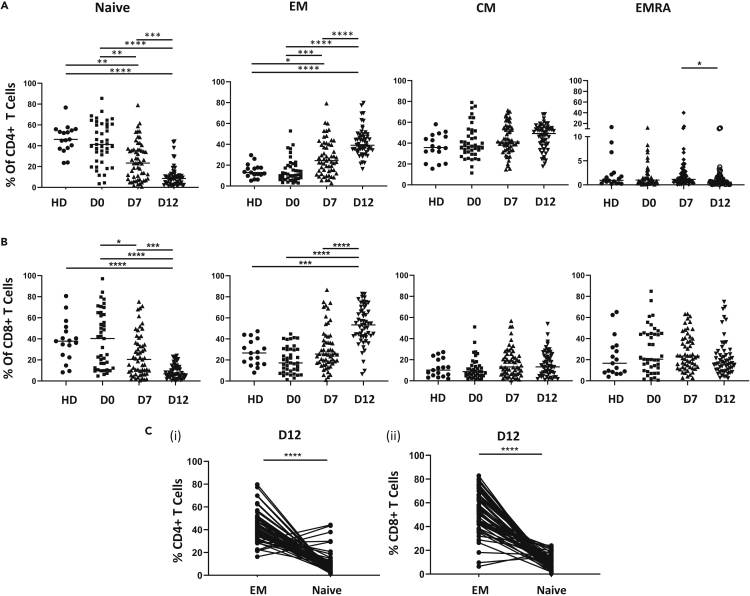
The proportion of naive T cells falls markedly after transplant whilst effector subsets increase(A and B)Percentage of T cell subsets in (A) CD4+ and (B) CD8+ population in healthy donors (HD, n = 17) and autograft patients at day 0 (D0 n = 41), at Day 7(D7, n = 57) and Day 12 (D12, n = 56) post-transplant.(C) Paired comparison of proportions of CD4+ (i) and CD8+ (ii) naive and effector memory (EM) subsets in each patient at day 12 post-transplant (n = 56). Bar indicates median value. Kruskal-Wallis test with Dunn's multiple comparison test (A,B) and Wilcoxon matched-pairs signed-ranks test (C) was performed for statistical analysis, ∗p < 0.05, ∗∗p < 0.01, ∗∗∗p < 0.001, ∗∗∗∗p < 0.0001.